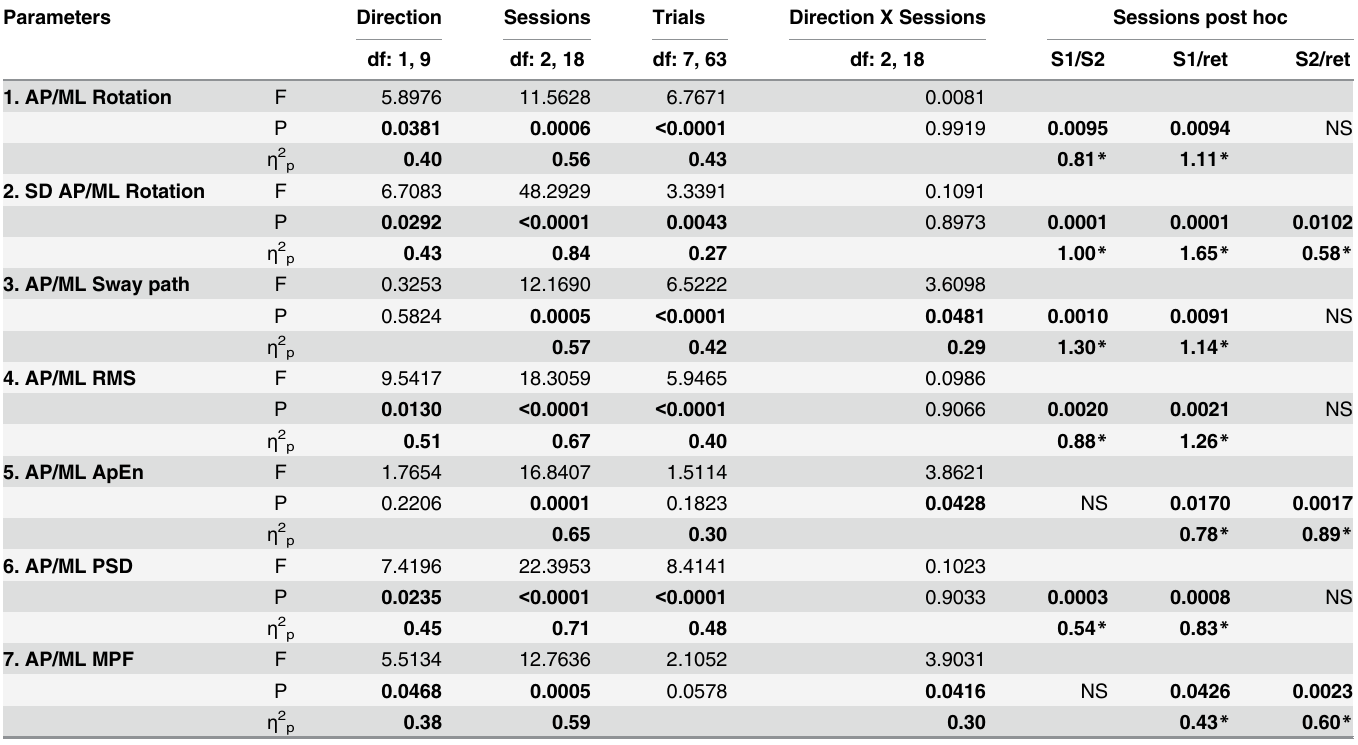
Table 2. Summary of statistical analysis for signals in AP and ML directions.